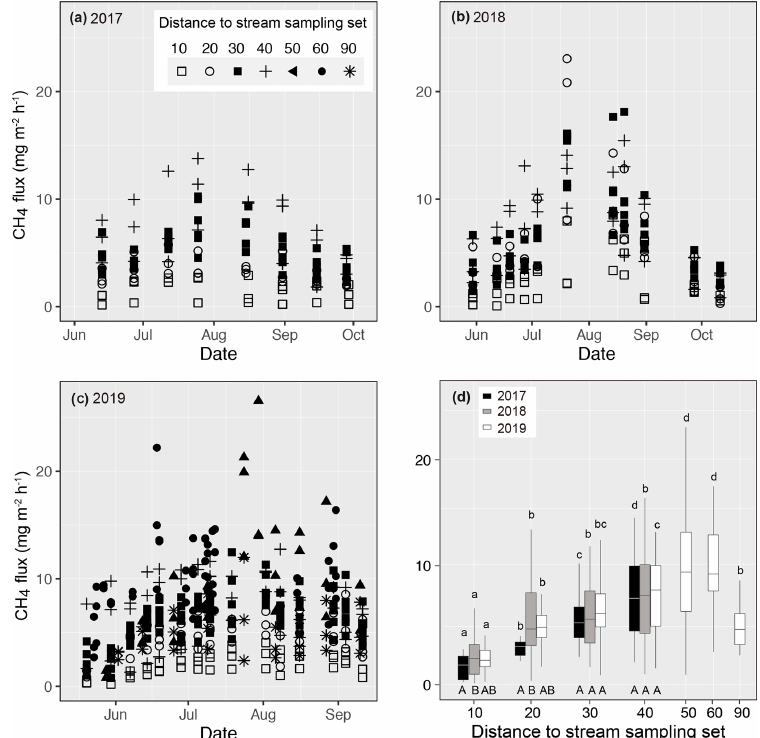
Figure 4. Measured methane (CH 4 ) fluxes during the growing season in (a) 2017, (b) 2018, and (c) 2019 at Lompolojänkkä. The distance from the sample plot sets to the stream are indicated by different symbols. (d) Box plots of CH 4 fluxes for each measurement set in 2017, 2018, and 2019. The different letters on top of the box plots indicate significant differences ( p < 0 . 05) between the sets for each year, calculated using Tukey’s honest significant difference method, and the different letters below the box plots indicate significant differences ( p < 0 . 05) between the studied years for each set.